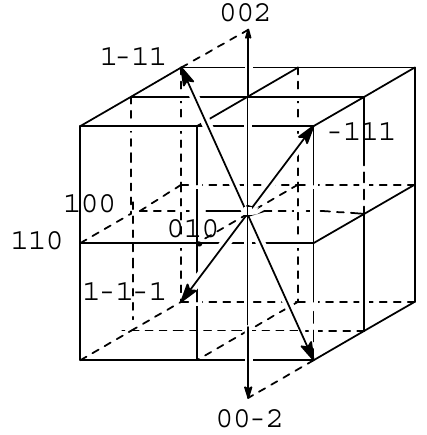
Figure 5. Crystallographic structure of the Ni-Cr phase.